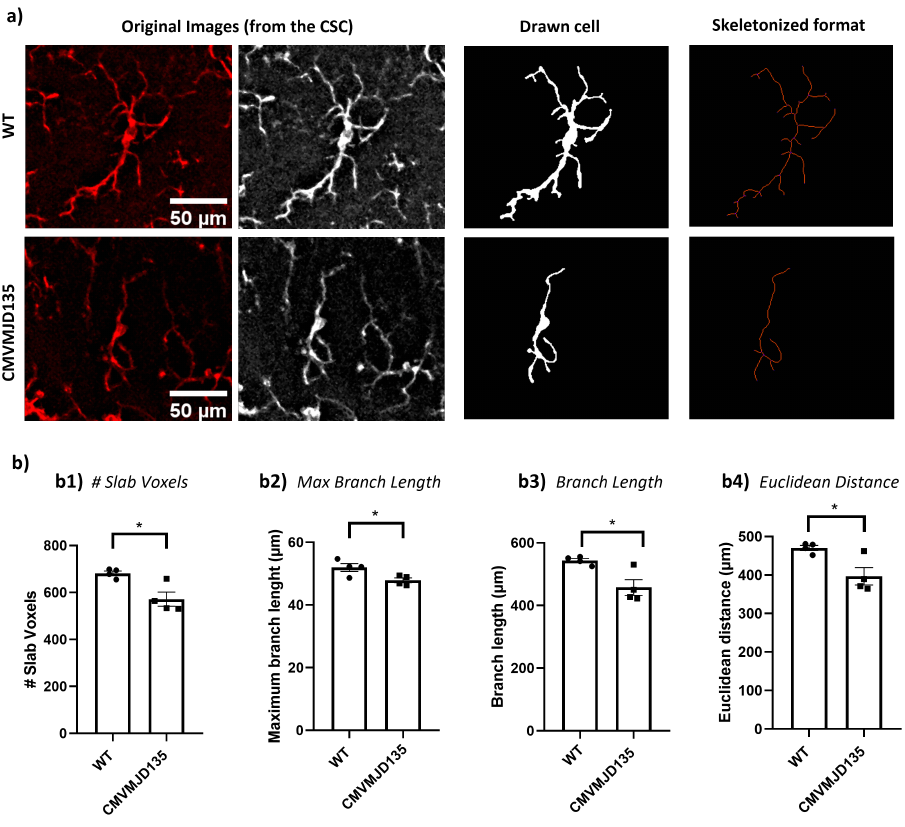
Figure 4. Microglia in the CSC of CMVMJD135 mice show less morphological complexity. ( a ) Repre- sentation of the process to prepare the images for skeleton analysis of microglia morphology. These images show differences regarding the number of slab voxels, the maximum branch length, the branch length, and the Euclidean distance. ( b ) Quantification of the morphometric features associated with microglia ramification, including: ( b1 ) # slab voxels; ( b2 ) maximum branch length; ( b3 ) branch length; and ( b4 ) Euclidean distance. Data of all these features were obtained from 310 microglial cells from WT mice ( n = 4) and 389 microglial cells from 34-week-old CMVMJD135 mice ( n = 4) of the CSC. Data are presented as mean + SEM (Student’s t -test). *, represent p < 0.05. Scale bar: 50 µ